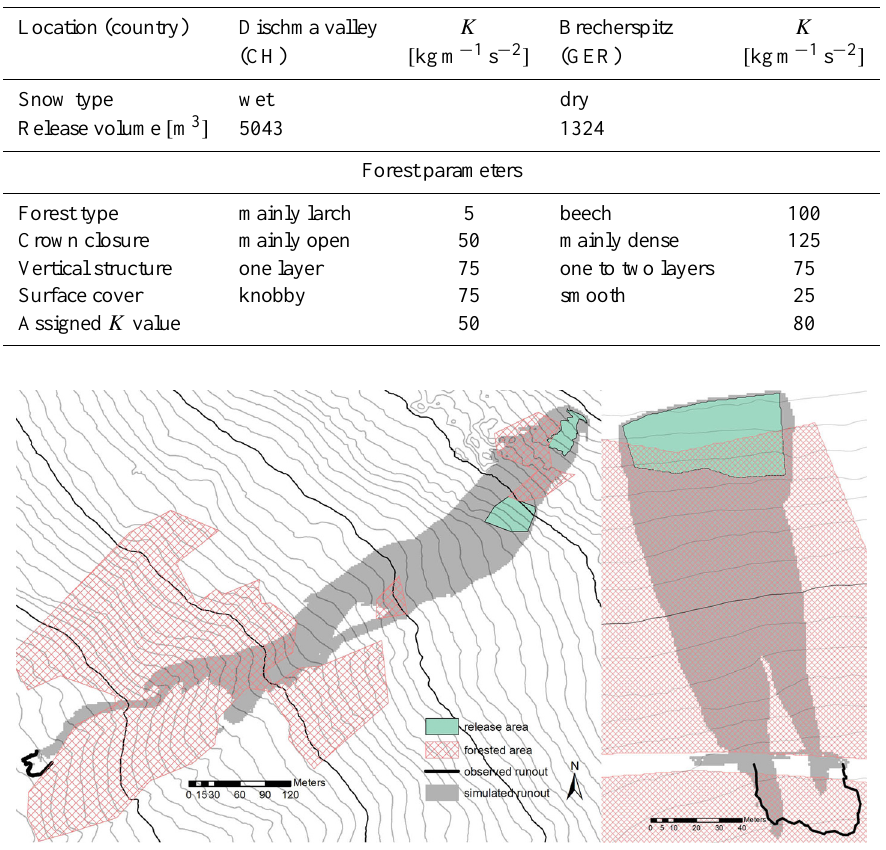
Figure 7. Simulation results gained with RAMMS including the detrainment function in comparison to the observed runout distances of the two case studies “Dischma valley” (left panel) and “Brecherspitz” (right panel). Contour lines are displayed in 10m